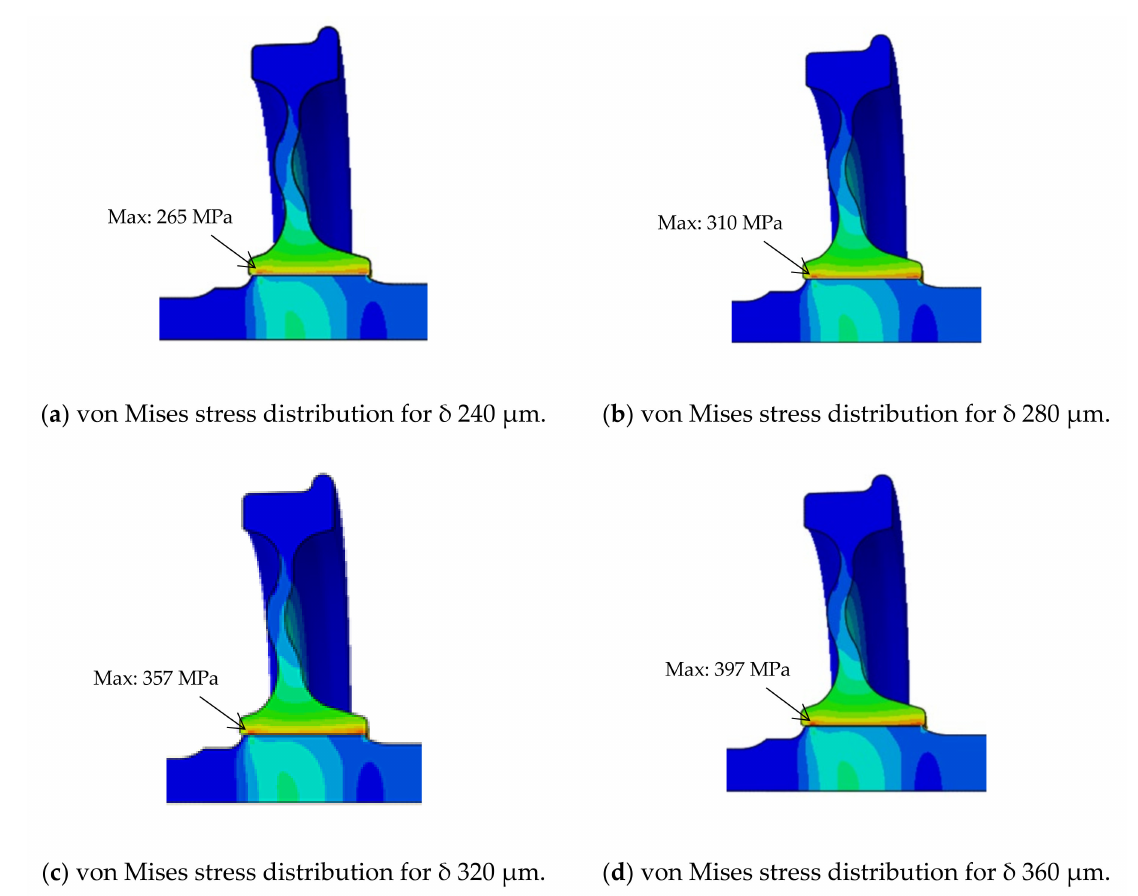
Figure 15. Von Mises stress of the wheel and axle due to radial interference (MPa).